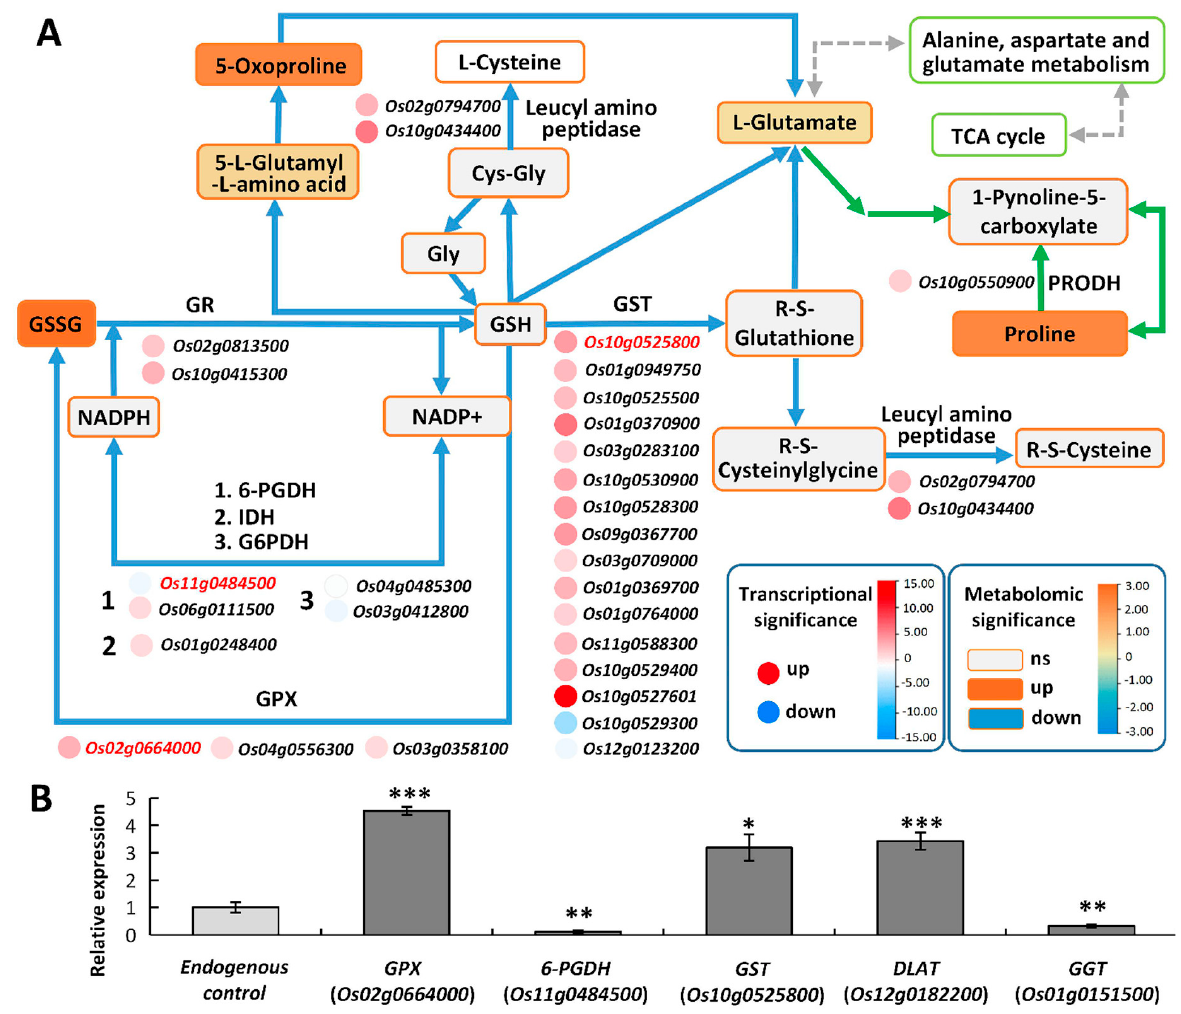
Figure 7. Overview of part of the glutathione metabolism pathway in response to HSA stress. ( A ) The DAMs and related DEGs involved in glutathione metabolism. The rectangles represent the metabolites. The colors of rectangles indicate significances which are presented in a color scale. Gray indicates no significance. The circles indicate DEGs. The colors indicate significances shown in a color scale. The solid lines with arrows indicate directions of the processes. The blue lines indicate processes in the glutathione metabolism pathway, and the green ones indicate processes in arginine and proline metabolism (part process related to proline production). Gray dotted lines indicate connection of other metabolism pathways. The genes highlighted by red were detected using RT − qPCR. ( B ) The gene expression levels were validated via RT − qPCR. Data are presented from three independent experiments performed with three replicates per experiment. *, p <